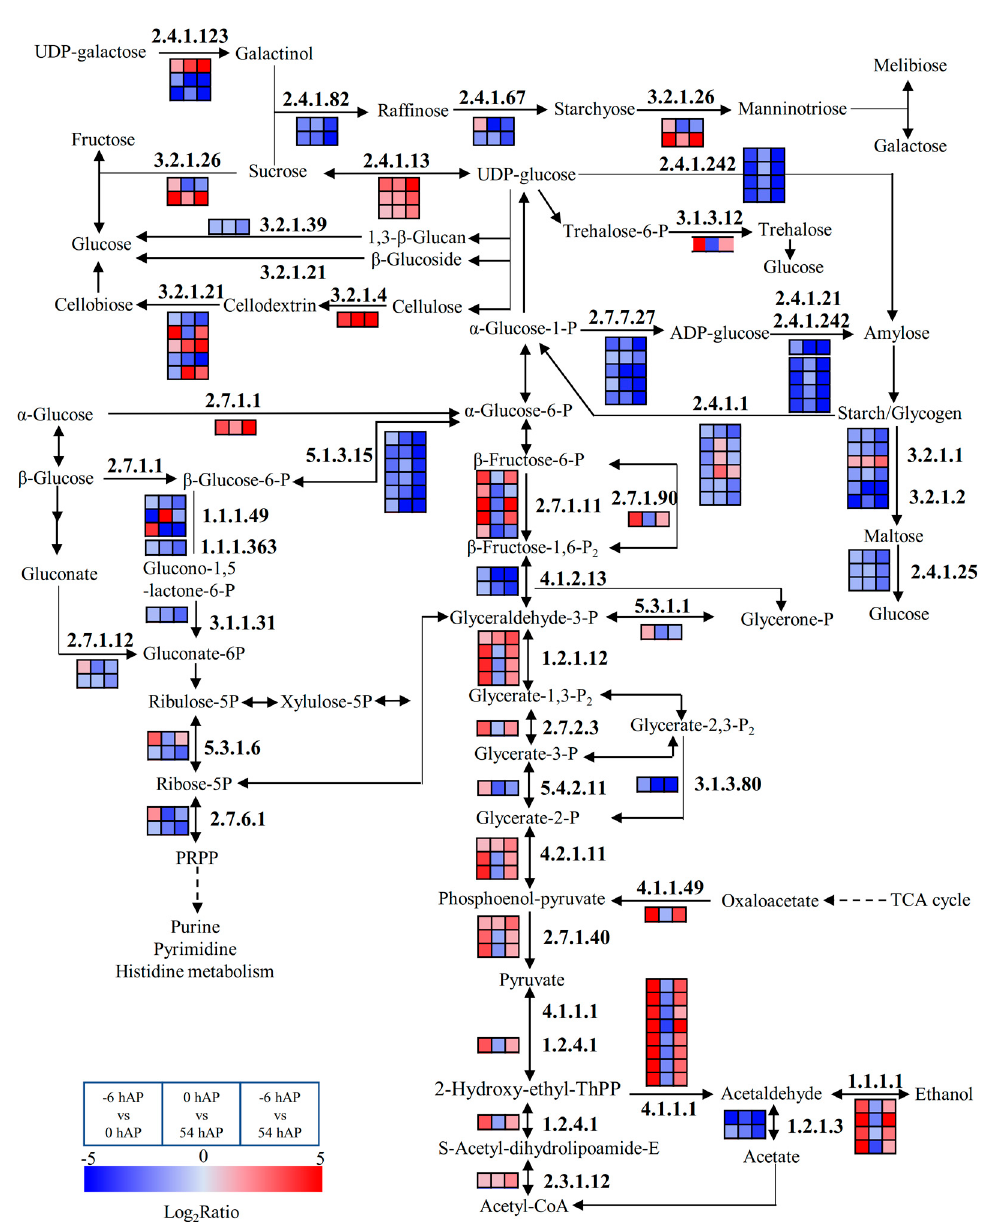
Figure 3. The significantly expressed common genes involved in starch and sucrose metabolism, glycolysis, pentose phosphate pathway and galactose metabolism during the early phases of AR formation in mulberry stem hardwood cuttings. The enzyme numbers of the enriched genes are in bold, and the changes of transcriptional expression levels in the three comparison groups are illustrated with colored boxes. The boxes from left to right indicate the expression values obtained in − 6 hAP vs. 0 hAP, 0 hAP vs. 54 hAP, and − 6 hAP vs. 54 hAP, respectively. Each row of boxes represents a mulberry homolog gene. The color code from blue to red represents the changes of transcriptional expression level between –5 and 5. This figure is redrawn based on the KEGG pathways.